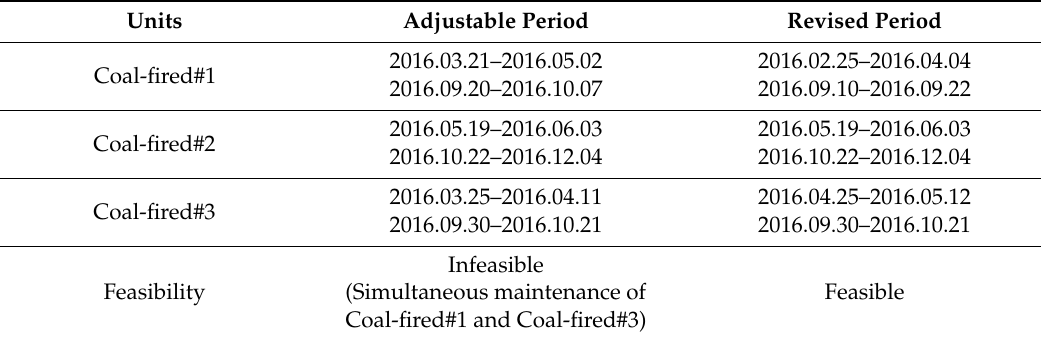
Table 3. Results of feasibility check for must-run units in Group 1.